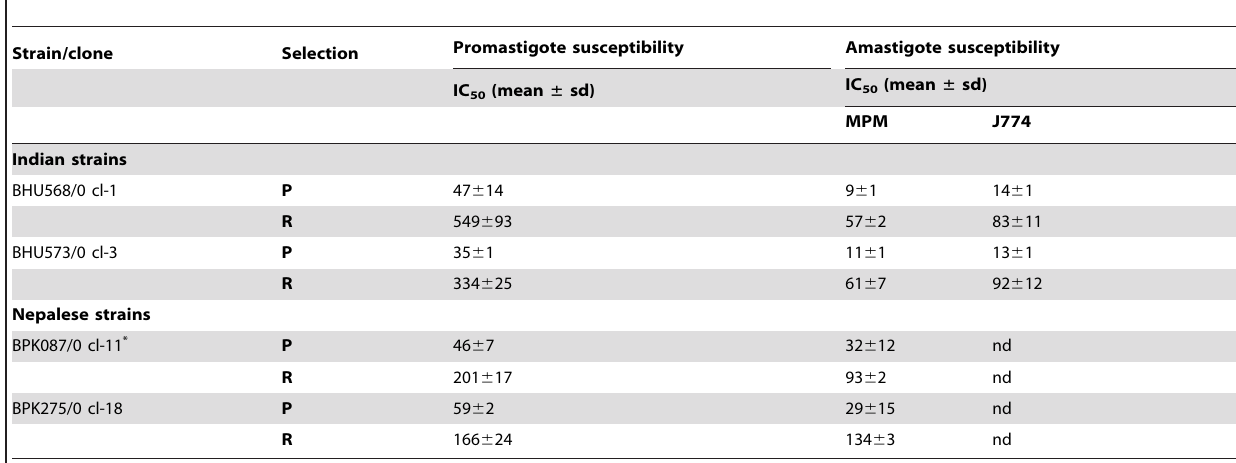
Table 1. PMM resistance selection in promastigotes: in vitro PMM susceptibility (IC 50 ) of L. donovani parasites cultured as promastigotes under increasing PMM drug pressure.